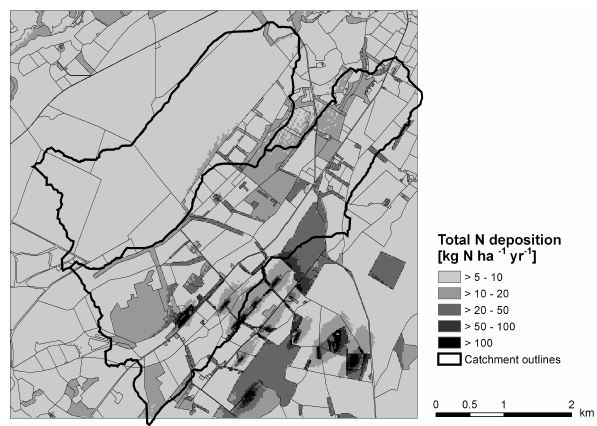
Fig. 3. Map of estimated total N deposition within the study land- scape. Source: Vogt et al.